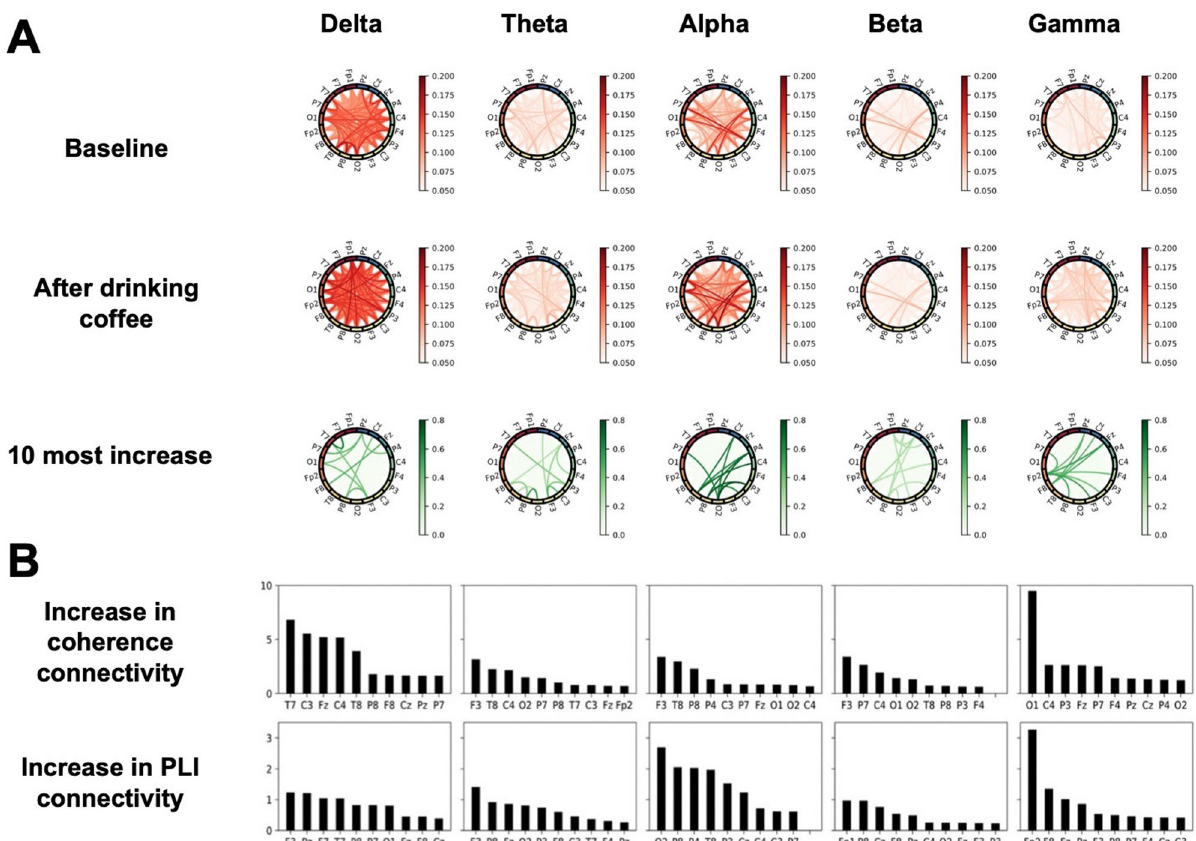
Figure 4. Phase lag index (PLI) averaged across all subjects and ten most highly increased nodes in each band. ( A ) Each column corresponds to a frequency band as indicated on the top of the figure. PLI matrices corresponding to the resting-state EEG before and after coffee consumption are plotted on the first and second rows, respectively; lines that have PLI values under 0.05 are not displayed. The third row plots the top 10 most increased lines. ( B ) The ten channels (nodes) with the highest increase in connectivity in terms of coherence (top row) and PLI (bottom row) are shown for each frequency band (corresponding to each column). Node connectivity was determined by taking the ten most highly increased links after coffee consumption from the averaged functional connectivity matrix (as in the third rows of Figs. 3C and A) and summing the weights of those edges connected to each node.